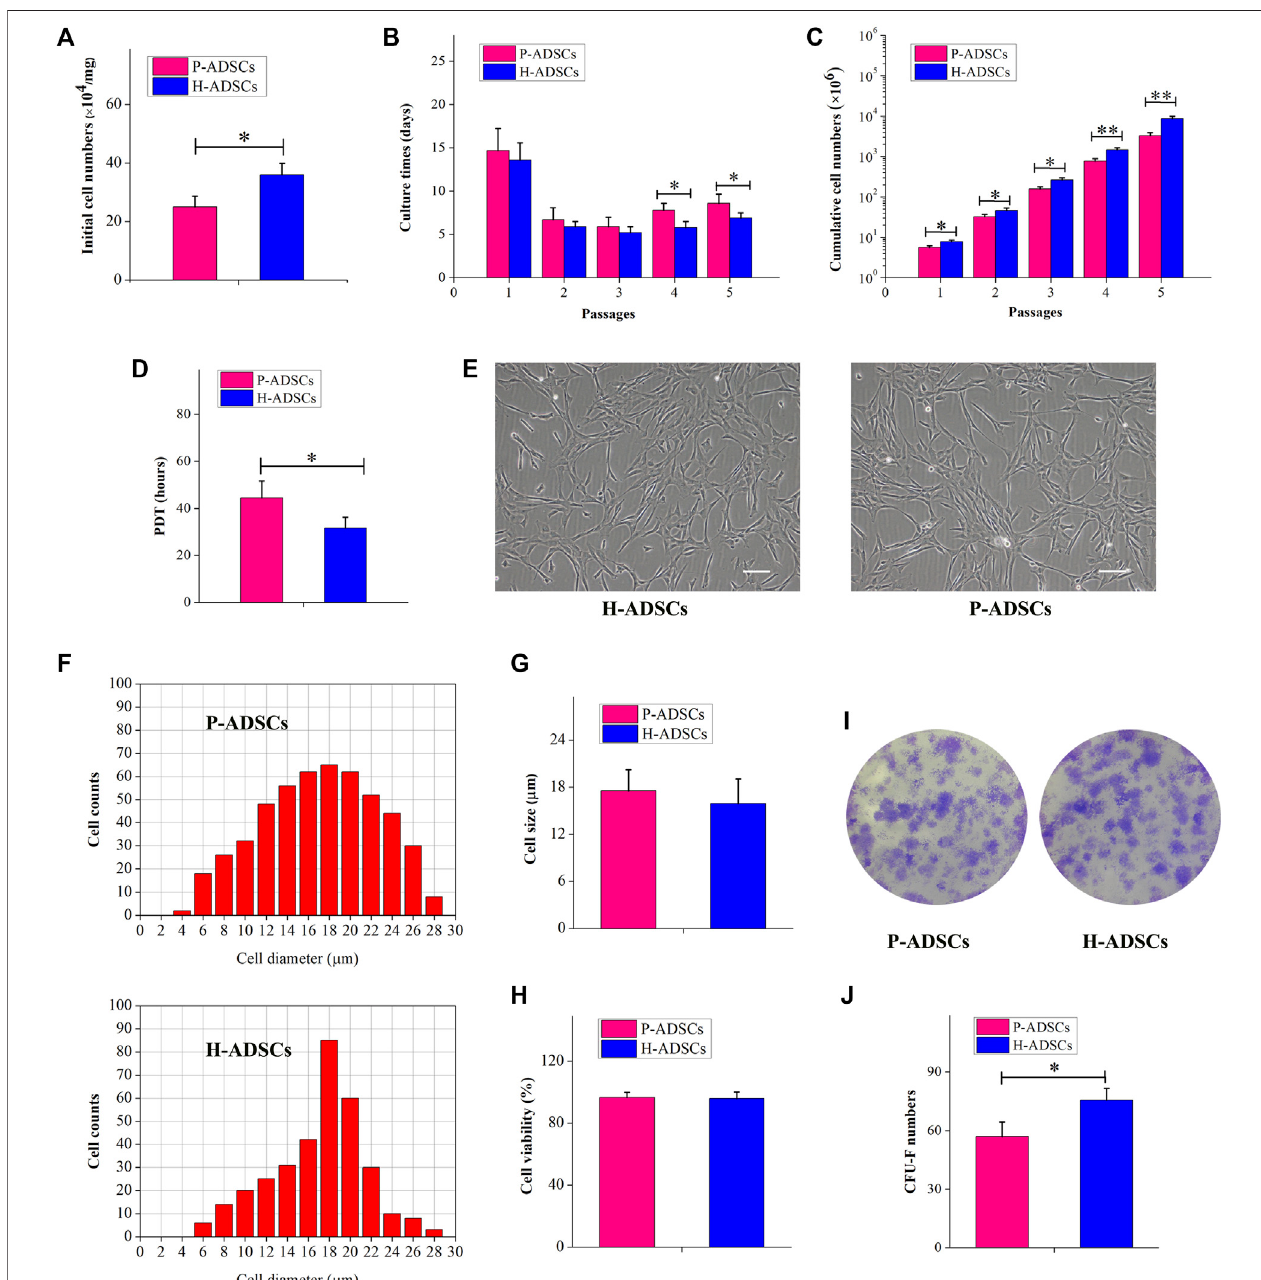
FIGURE 1 | Morphology and self-renewal characteristics of P-ADSCs and H-ADSCs (A) : Initial cell number per mg of AT cultivated in 5% hPL. n = 7; * p < .05 determined by the Wilcoxon-Mann-Whitney nonparametric test (B) : Culture days after a series of passages. n = 7; * p < .05 determined by the Wilcoxon-Mann-Whitney nonparametrictest (C) :Cumulativecellnumbersasafunctionofpassage. n =7;* p < .05and** p < .01determinedbytheWilcoxon — Mann-Whitneynonparametrictest. (D) : Population doubling time of P-ADSCs or H-ADSCs. n = 7; * p < .05 determined by the Wilcoxon-Mann — Whitney nonparametric test (E) : Morphological characteristics of P-ADSCs or H-ADSCs cultivated in 5% hPL at passage 5. Representative images are shown. Scale bar = 100 μ m. (F) : Cell diameter histogram of P-ADSCs or H-ADSCs at passage 5. The cell diameter of monodispersed cells was also determined by image analysis, using the Cellometer Auto T4. Representative images are shown. (G) : Cell sizes of P-ADSCs or H-ADSCs. (H) : Cell viability of P-ADSCs or H-ADSCs cultivated in 5% hPL at passage 5. (I) : Crystal violet-stained after 14daysinculture.Representativeimagesareshown(×4) (J) :CFU-FnumbersofP-ADSCsorH-ADSCscultivatedin5%hPLatpassage5(* p < .05and** p < .01; n =7). determining region Y-box 9 (SOX-9) and collagen Ⅱ at days 14 and 21 after differentiation, indicated that staining ( Figure 3D ). The relative expression of sex- P-ADSCs at passage fi ve had a signi fi cantly lower